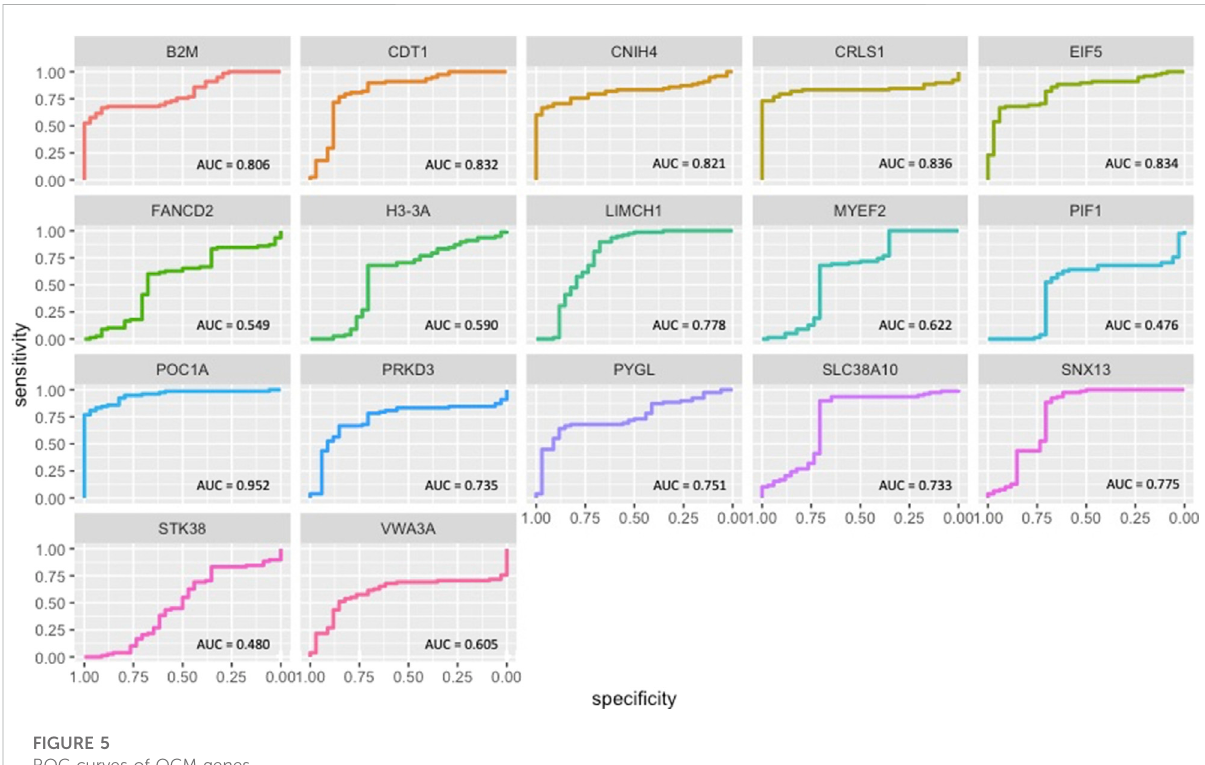
FIGURE 5 ROC curves of OCM